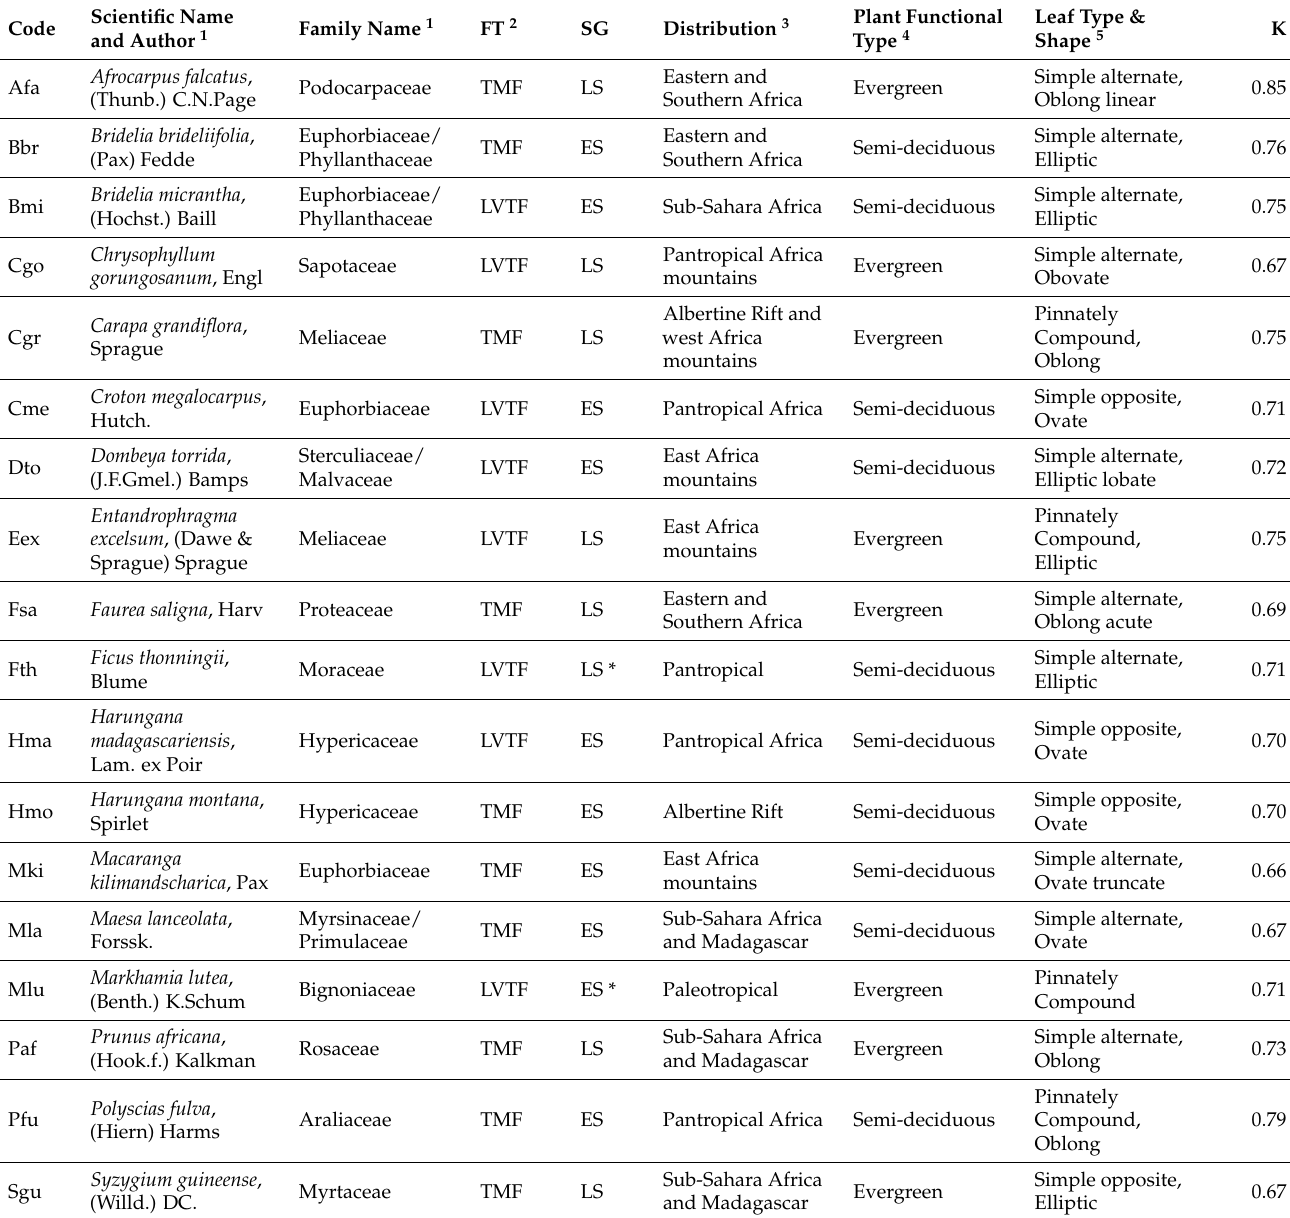
Table 2. Taxonomy for species and their main forest type of origin, classification into successional group as well as their leaf type and shape. FT, forest type of origin; TMF, tropical montane forest (~>2000 m a.s.l.); LVTF, Lake Victoria Transitional Forest (~1500–2000 m a.s.l.); SG, successional group (ES, early LS, late); K, leaf area factor; *, species with mixed successional group